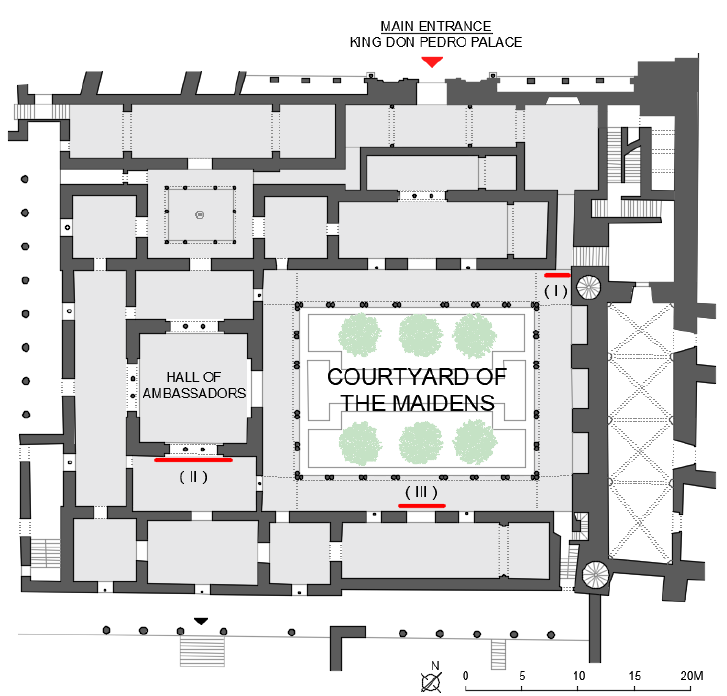
Figure 1. Ground floor plan of the Palace of Pedro I (RAS). Location of the three areas studied in this work: (i) Secondary entrance to the Courtyard of the Maidens, (ii) Entrance to the Hall of Am- bassadors through the Toledanos Room, and (iii) Entrance to the Room of the Carlos V ceiling.